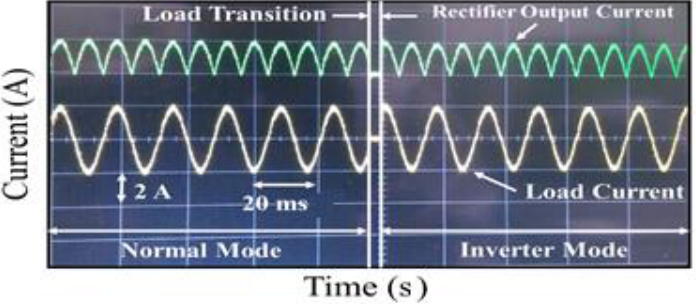
Figure 27. Experimental waveform of load current ( I Load ), and rectifier output current for the proposed single-phase offline UPS system while powering a transformer-coupled uncontrolled rectifier load during inverter mode.